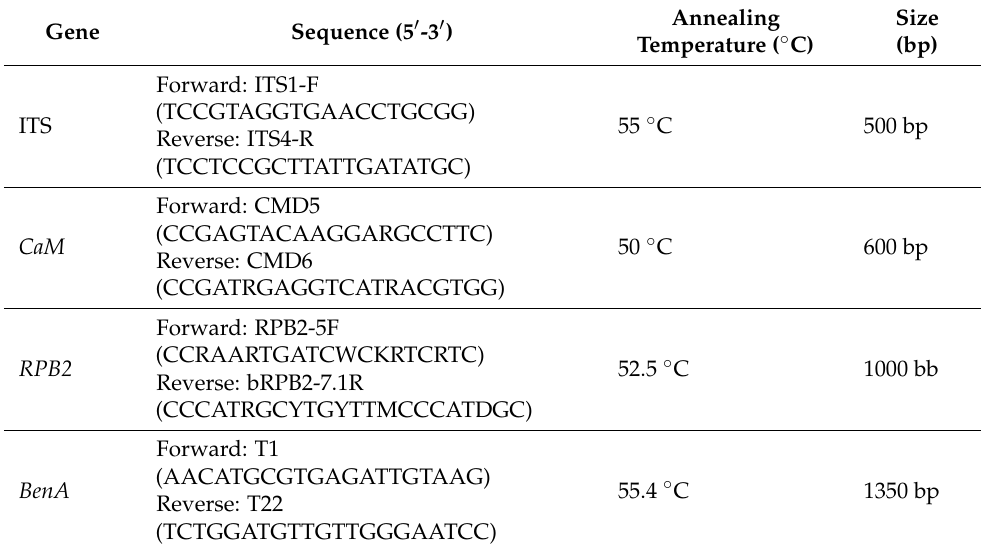
Table 1. PCR amplification parameters and sequencing primers used for the identification of the fungal